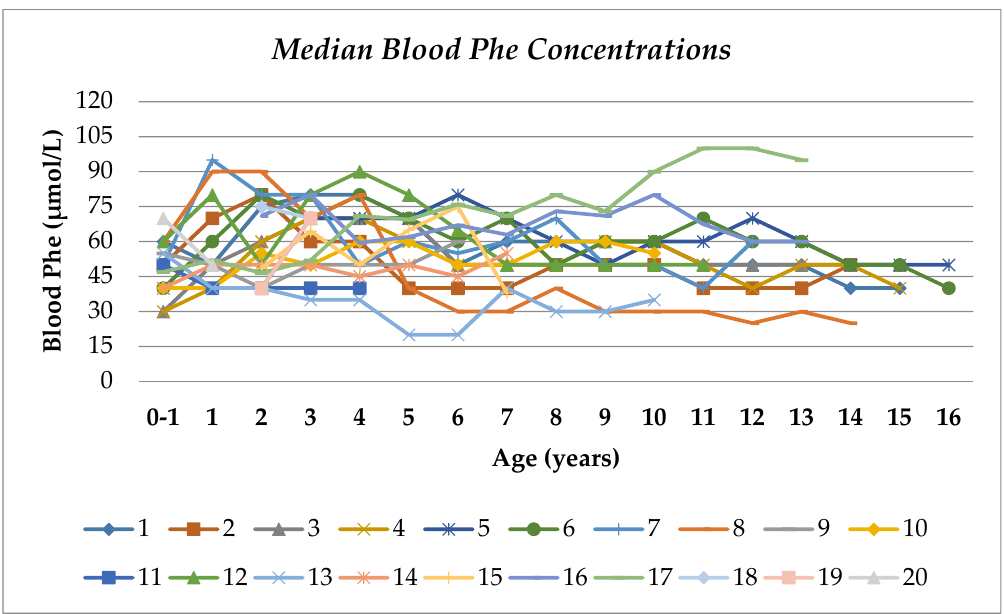
Figure 1. Median blood Tyr concentrations by age in patients with HTI. Coloured lines represent individual patients.